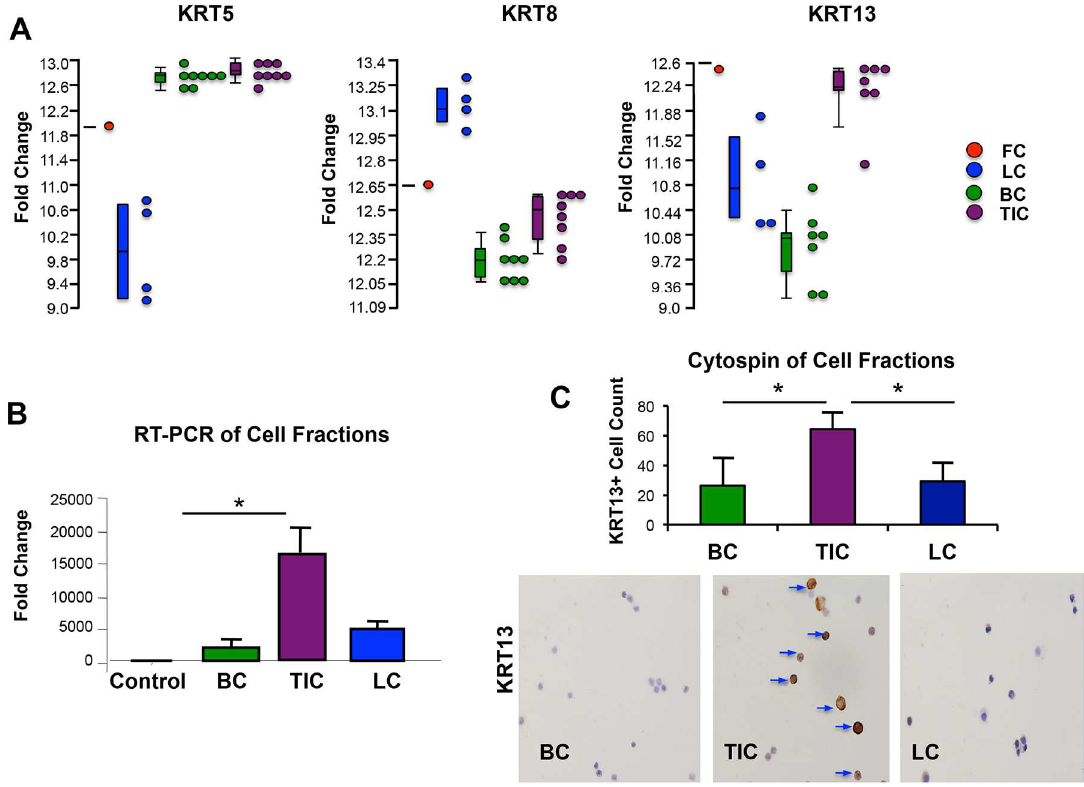
Fig 1. Differential KRT expression in fractionated prostate epithelial cells. (A). Differential expression of the basal KRT5, luminal KRT 8 and KRT 13 among the four cell populationsanalyzed(FC-red dot, LC-blue dots, BC-green dots, and TIC-purple dots) from the Affymetrix Gene Chip Human U133 PLUS 2.0 Array analysis. Each dot represents an individual sample, with the exceptionof the FC, where 6 samples were pooledto generatesufficient RNA for analysis. (B) RNA was isolated from sorted cell fractions generatedfrom 3 uniqueprostate tissue specimens and evaluated via Quantitative RT-PCR. Unfractionated total prostate cell control is represented by the black column, Epcam + CD44 + CD49f Hi basal cells (BC) represented by green column, Epcam + CD44 - CD49f hi tubule initiatingcells (TIC) represented by purple column, and Epcam + CD44 - CD49f Lo luminal cells (LC) represented by blue column. TIC had significantly higher expression than BC (p < 0.05). (C) KRT13 immunostaining of cytospin slides of sorted cell fractions (BC, TIC, and LC) demonstrates relative abundanceof KRT13 + cells, designated by brown staining, within the TIC fraction relative to BC and LC. The bar graph demonstrates the averagecell count of KRT13 + cells per/cytospin slide (averageof 3–5 slides, P < 0.05).